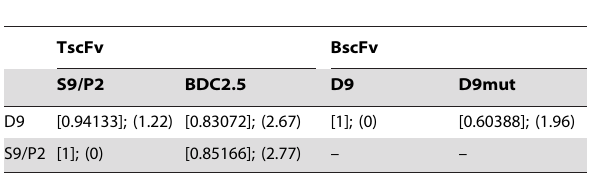
Table 1. Template modeling scores [TM] and root mean square deviation scores (RMSD) for the comparison of structural similarities between